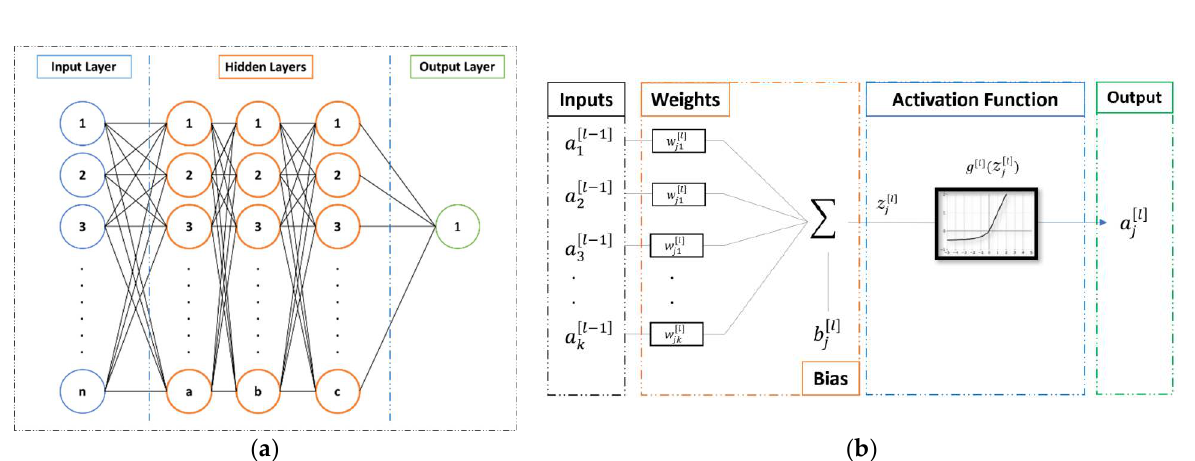
Figure 7. ( a ) Neural network representation, and ( b ) a single neuron.